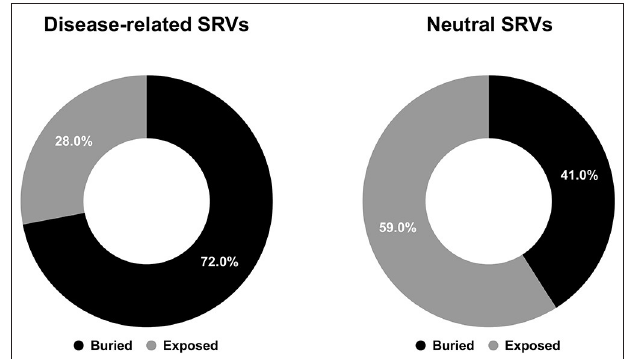
FIGURE 4 | Pie charts showing the fractions of predicted buried/exposed positions disease-related (left) and neutral (right) upon variations in the HVARSEQ dataset,